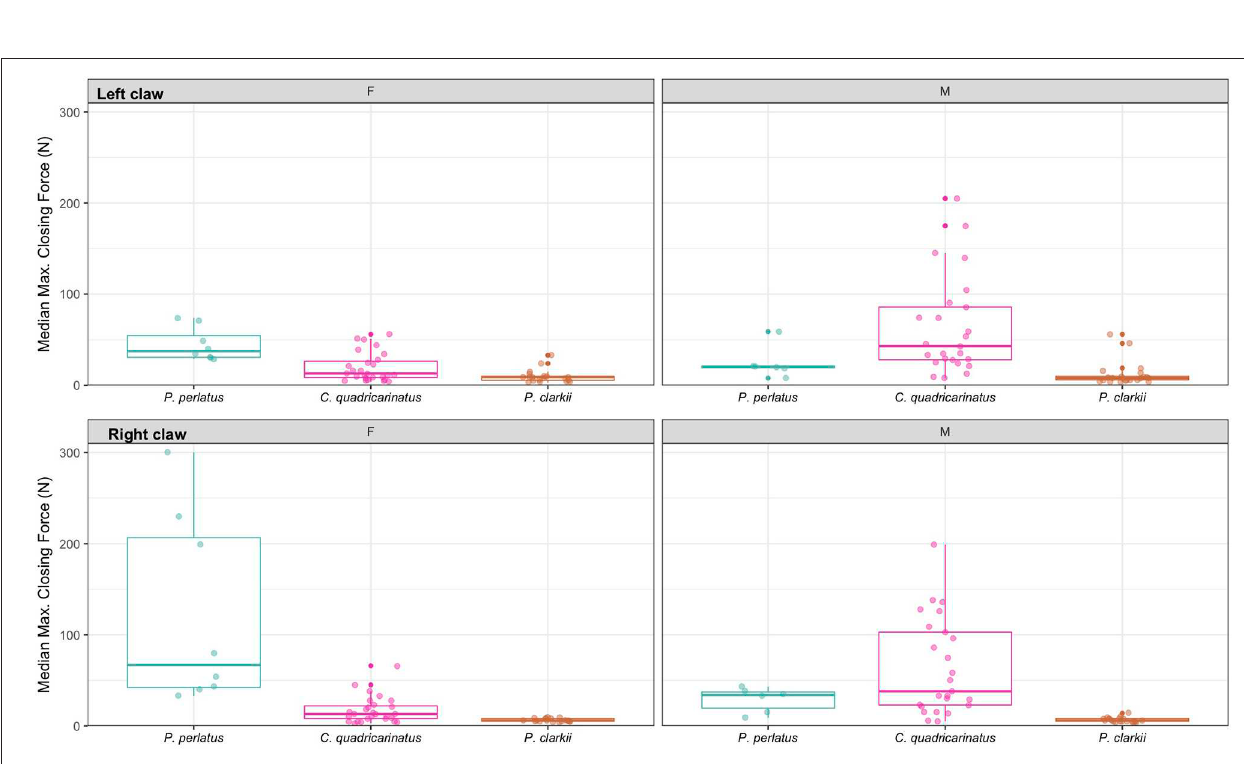
Frontiers in Ecology and Evolution |